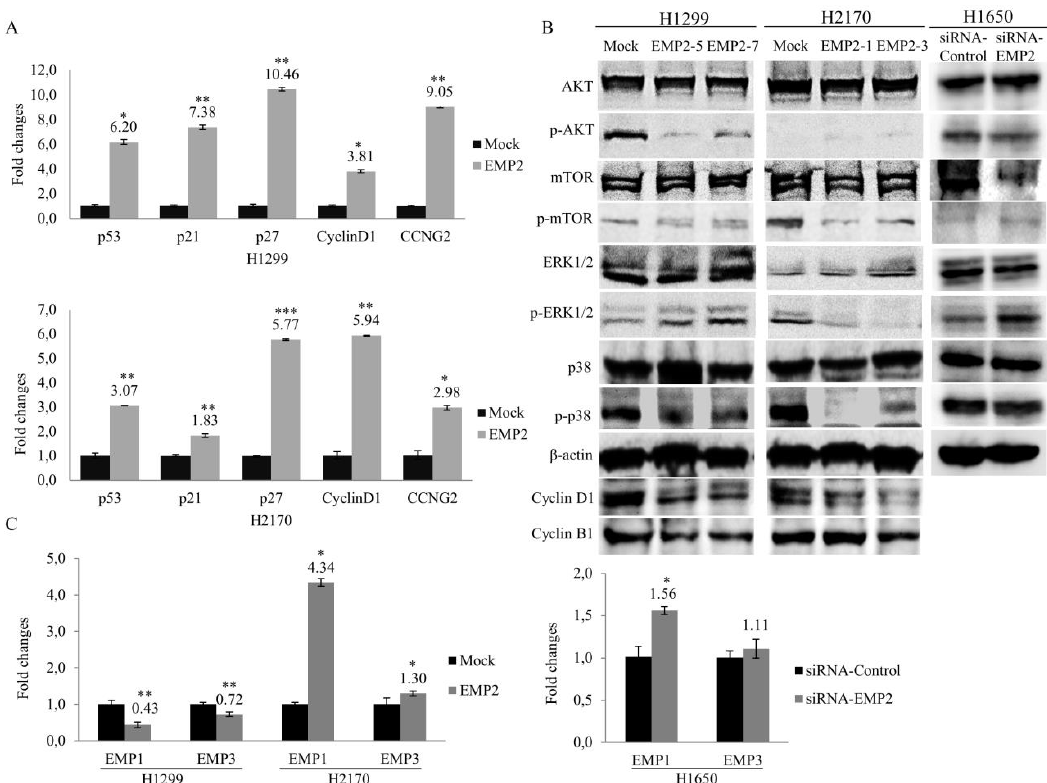
Figure 5. Influence of EMP2 on cell cycle regulatory genes/proteins and tumor-associated signal pathways. ( A ) Real-time RT-PCR analysis revealed altered expression of cell cycle regulatory genes in both H1299 and H2170 cells after EMP2 stable transfection. ( B ) Western blot analysis showed decreased phosphorylated levels of AKT and p38 as well as decreased protein expression levels of cell cycle regulators cyclin D1 and cyclin B1, and an increased phosphorylated level of ERK1/2 in H2199 cells. In H2170 cells, decreased phosphorylated levels of mTOR, ERK1/2, and p38 as well as decreased protein expression levels of cyclin D1 and cyclin B1 (clone EMP2-3) after EMP2 overexpression were found. An increased phosphorylated level of ERK1/2 after EMP2-knockdown was detected in H1650 cells ( C ) Influence of EMP2 overexpression (left) and knockdown (right) on EMP1 and EMP3 expression. * p < 0.05, ** p < 0.01, *** p < 0.001 when analyzed using Student’s t -test.